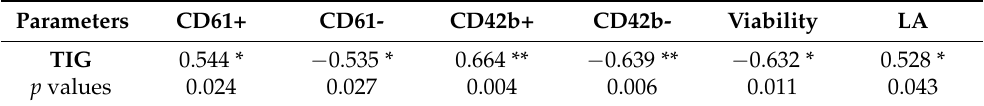
Table 8. Tissue inflammation grade (TIG) correlated with adhesion glycoproteins expressions, cell viability, and late cell apoptosis.